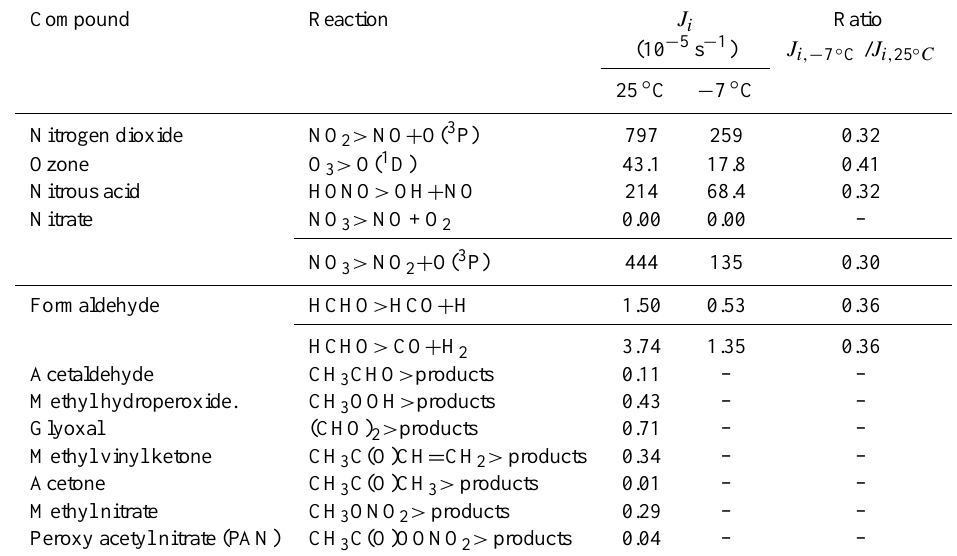
Table 5. Predicted gas phase photolysis rates of selected compounds in the mobile smog chamber at 25 ◦ C and − 7 ◦ C. Compound